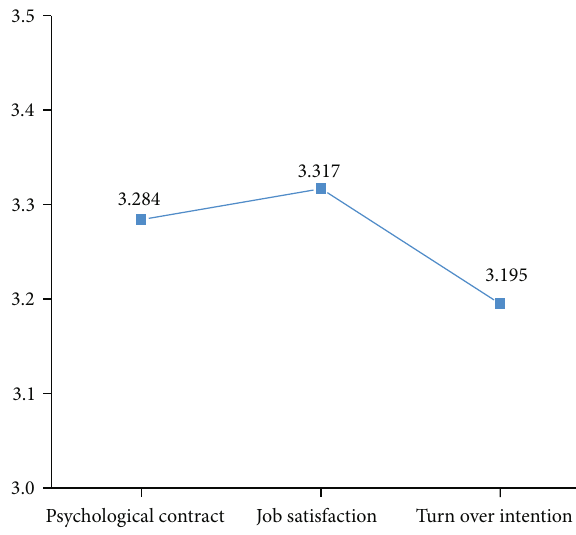
Figure 2: Comparison of mean values of each variable. Figure 3: Comparison of the mean values of di ff erent gender